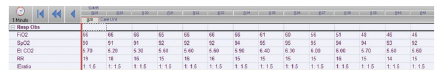
Figure 4: Screenshot of sequential FiO 2 and SpO 2 values at one- minute intervals upon moving the patient from a semirecumbent to supine